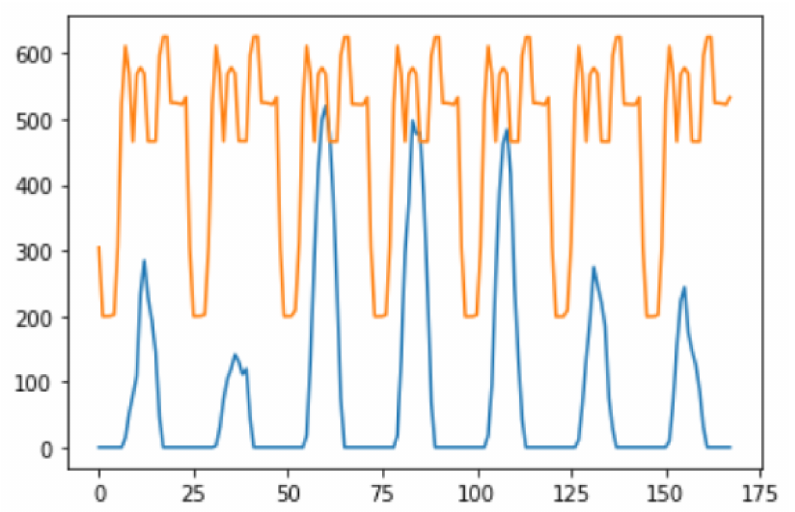
Figure 6. PV and load for 7 days.